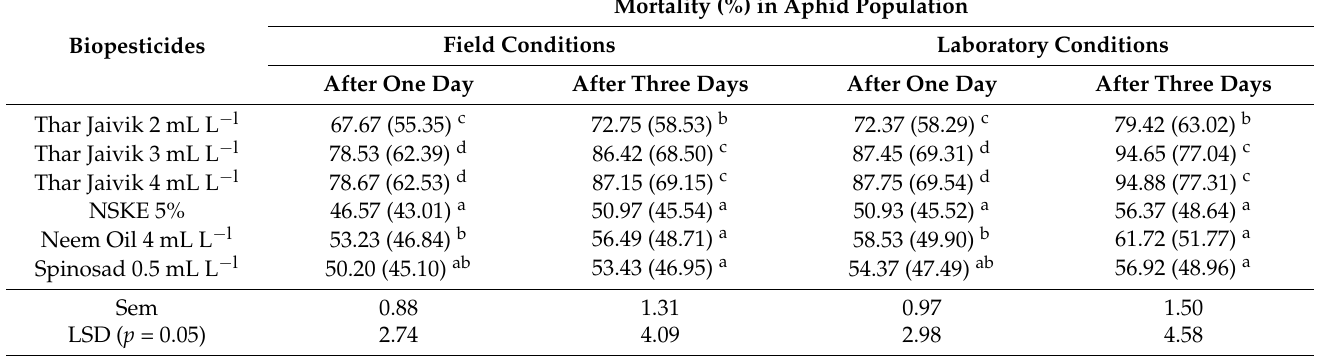
Table 3. Efficacy of “Thar Jaivik 41 EC” and other biopesticides used at different concentrations against T. citricida on citrus plant (pooled data, 2018 and 2019).